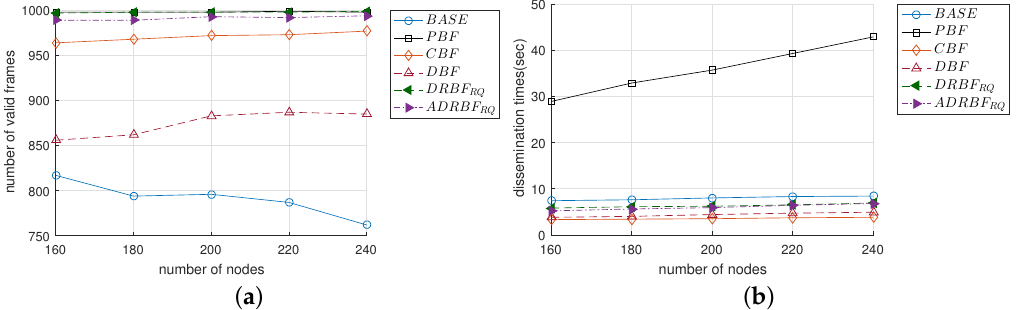
Figure 16. The performance comparison of the flooding mechanisms when the network radius was extended to 3 D tx : ( a ) the number of valid frames F val and ( b ) the dissemination time T dis